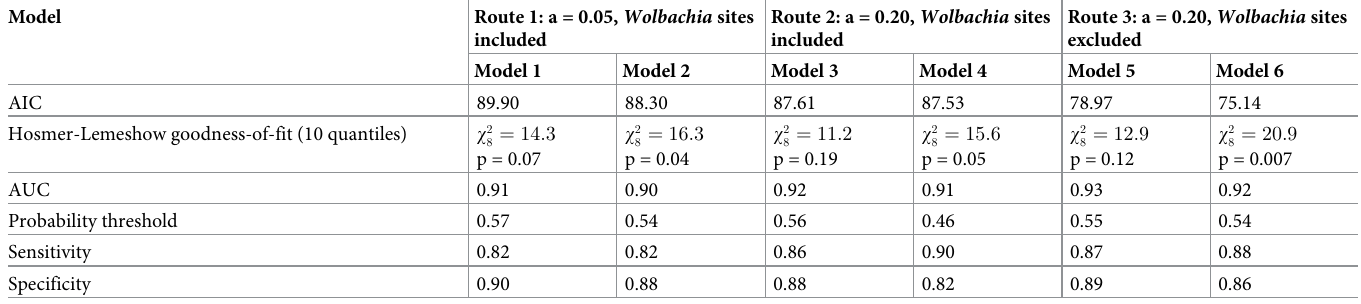
that excluding Wolbachia sites were included in Model 5. After applying the backward step- wise selection method, Models 2, 4 and 6 retained variables with p-values below the corre- sponding level of significance from Models 1, 3 and 5 respectively. Public cleanliness was removed from Model 4 despite retaining significance due to the change in direction of the coefficient in the multivariable model compared to the unadjusted model. Variance inflation factors of all variables in Models 1 to 6 were below the value of 3, demonstrating modest multi- collinearity. Table 4 shows AIC, Hosmer-Lemeshow χ 2 and p-values, AUC, probability thresholds, sen- sitivity and specificity levels for each multivariable model. Probability thresholds were selected Table 4. Comparison of multivariable